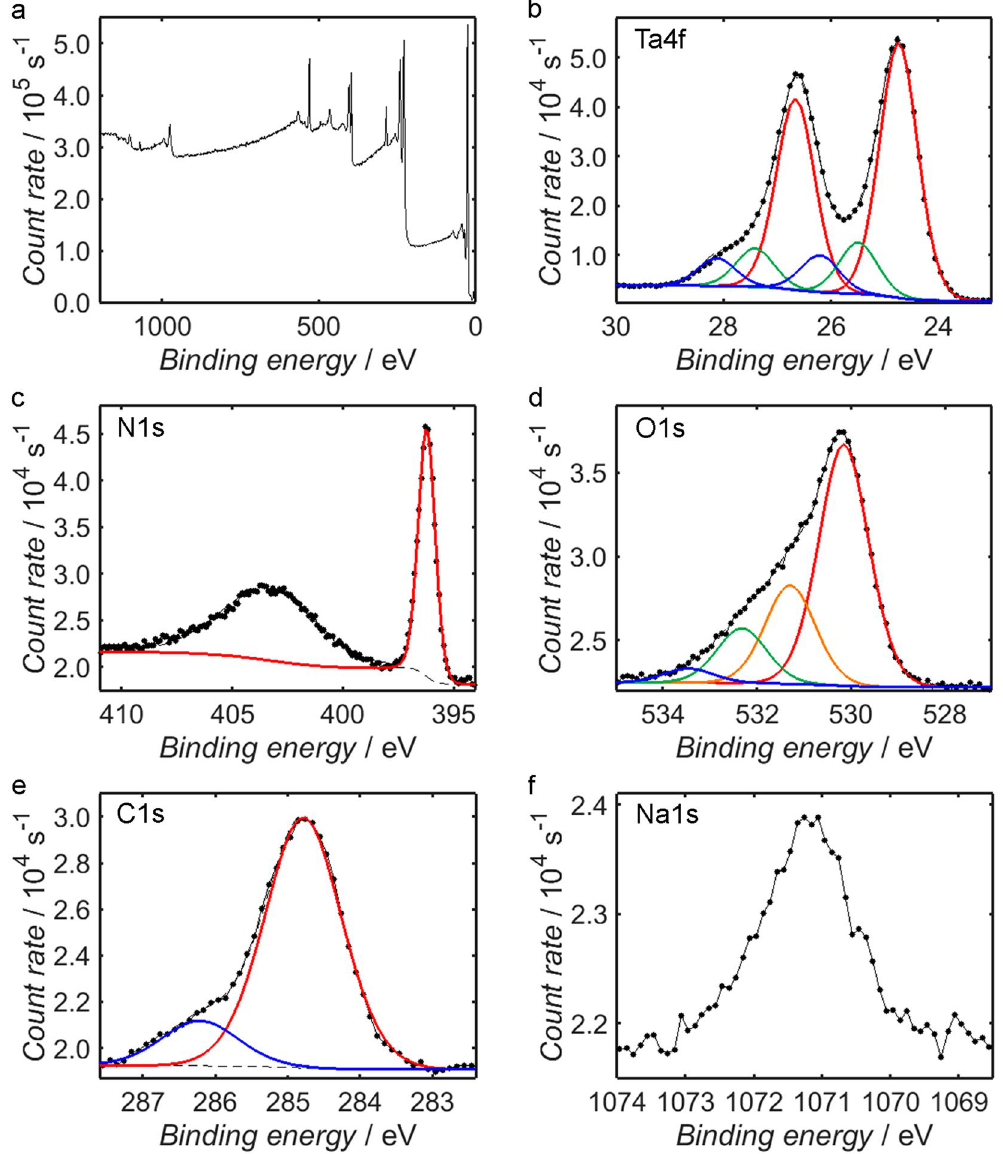
Figure 3. XPS measurements of the Ta 3 N 5 binding energy spectrum over the range 0–1200 eV ( a ), in addition to higher resolution measurements of the Ta4f ( b ), N1s ( c ), O1s ( d ), C1s ( e ) and Na1s ( f ) peaks. Shirley fits to secondary electron backgrounds are shown as black dashed lines, while fitted peak components are plotted as solid, coloured lines; fitted peaks contained within the same doublet have been assigned the same